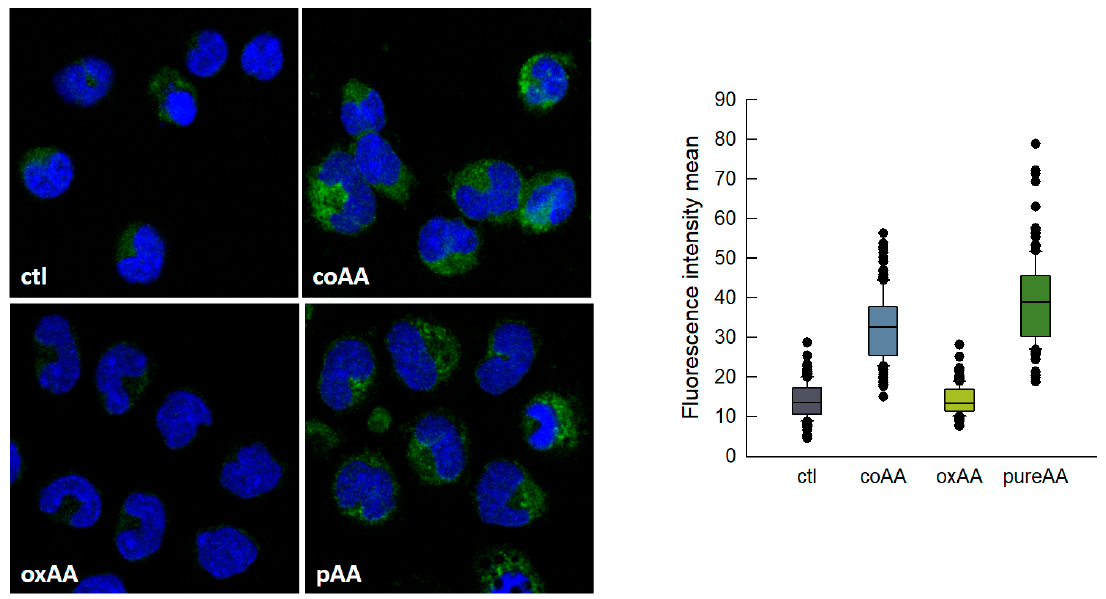
Figure 3. AA-induced lipid droplets (LDs) formation in human monocytes. Monocytes were untreated (ctl) or treated with commercial AA (coAA), oxidized AA (oxAA) or pure AA (pAA) for 2 h, as indicated. In all cases, the fatty acid was added at a concentration of 10 µM. After fixation and permeabilization, cells were stained with boron-dipyrromethene (BODIPY) 493/503 (2 µg/mL) to visualize LD (green) and 4’,6’-diamidino-2-phenylindole (DAPI) (1 µg/mL) to mark the nuclei (blue). Cells were then analyzed by confocal microscopy (original magnification 630×). The boxplot on the right shows the distribution of the fluorescence intensity data based on a summary of median, minimum, maximum and quartiles from at least 150 cells in two independent experiments.